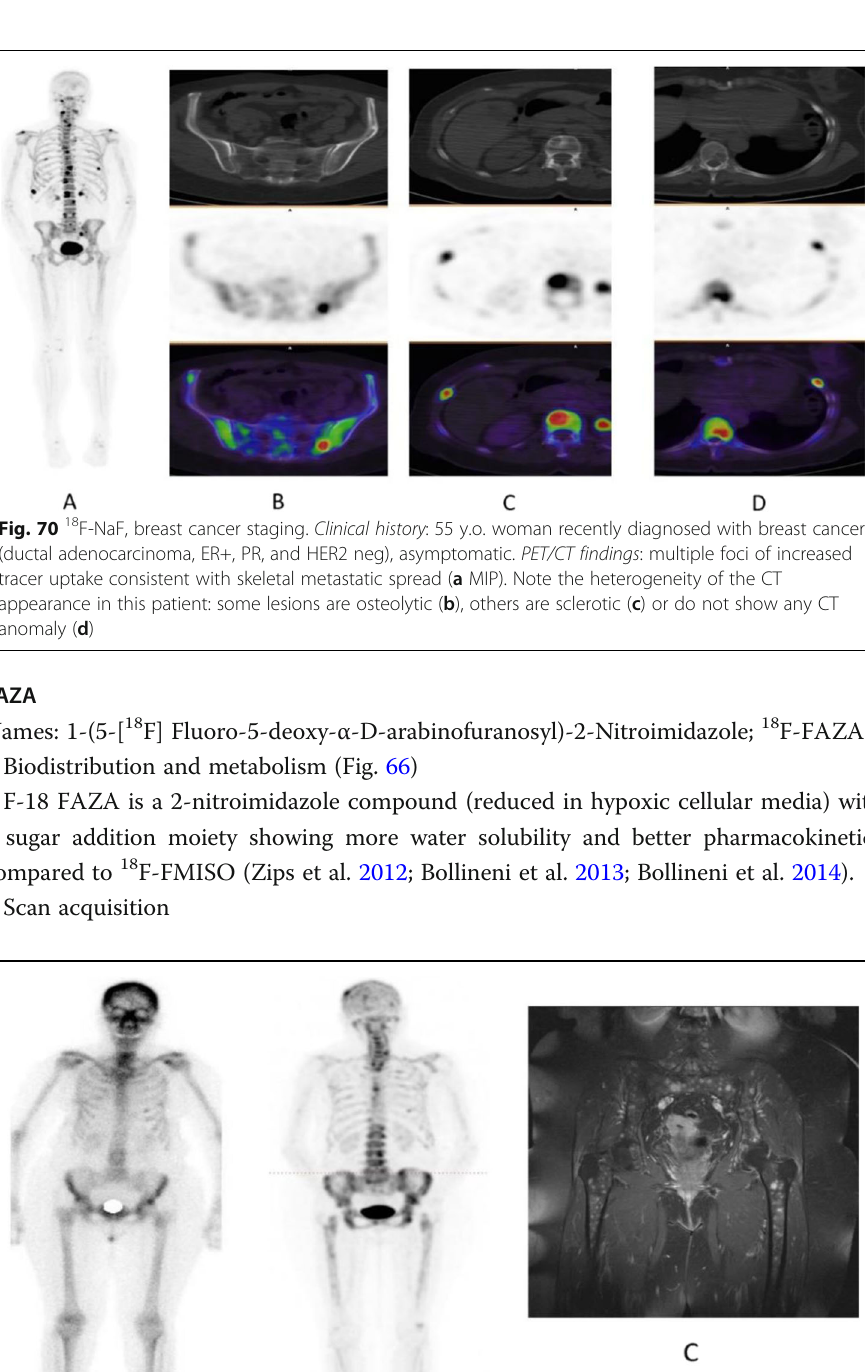
Fig. 71 18F-NaF, breast cancer restaging. Clinical history : 72 y.o. woman with history of breast cancer (infiltrating ductal carcinoma, ER+, PR, and HER2 neg). Diffuse bone pain, no evidence of bone metastases on bone scintigraphy ( a anterior view). PET/CT findings : highly heterogeneous uptake in the cranium, spine, pelvic grid and femurs, consistent with bone marrow involvement ( b MIP). MRI confirms multiple small sized lesions ( c